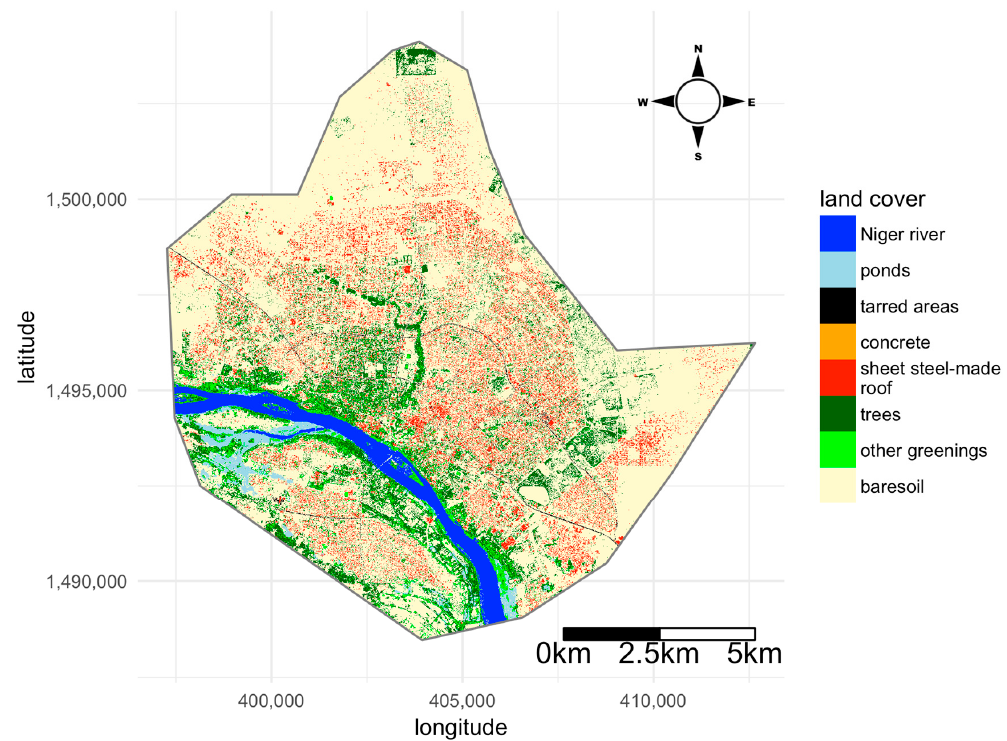
Figure 1. Map of the city of Niamey (Niger) showing the 8 land-cover classes used in the study. The projected coordinate system is WGS 84 / UTM zone 31N (EPSG: 32631, http://spatialreference.org/ref/epsg/32631/).